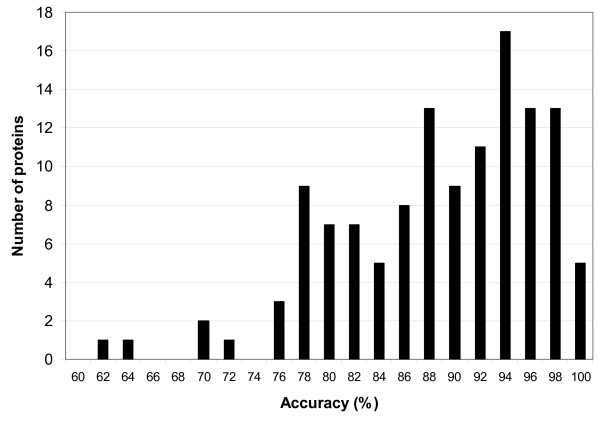
Histogram illustrating the distribution of accuracy (Q3) scores (%) of the consensus prediction from PROTEUS as measured on the test set of 125 proteins. The mean is 87.8% and the standard deviation is 10.2%.